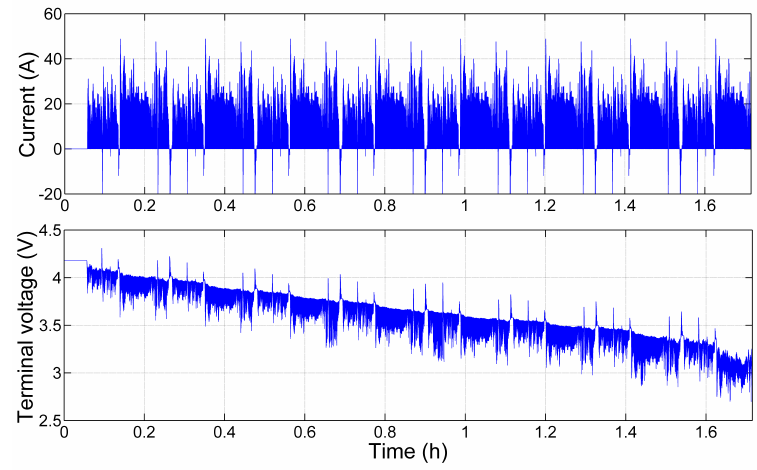
Figure 12. Current and terminal voltage profiles of HWFET.